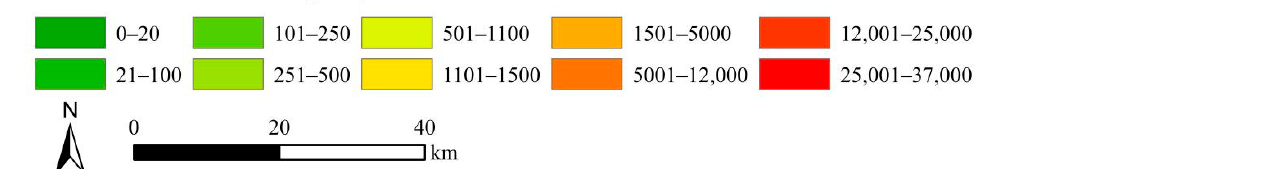
Figure 5. Direct house losses in different assessment units of Haikou City in different flood return periods. ( a ) 10-year, ( b ) 20-year, ( c ) 50-year, ( d ) 100-year. Note: The numbers represent assessment units.